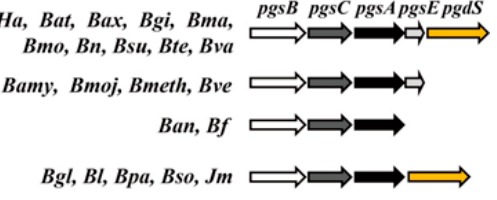
Figure 8. pgsBCAE and pgdS gene clusters. Bat , Bacillus atrophaeus ; Bax , Bacillus axarquiensis ; Bgi , Bacillus gibsonii ; Bma , Bacillus malacitensis ; Bmo , Bacillus mojavensis ; Bn , Bacillus nakamurai ; Bsu , Bacillus subtilis ; Bte , Bacillus thuringiensis ; Bva , Bacillus vallismortis ; Bamy , Bacillus amyloliquefaciens ; Bmoj , Bacillus mojavensis ; Bmeth , Bacillus methylotrophicus ; Bve , Bacillus velezensis ; Ban , Bacillus anthracis ; Bf , Bacillus flexus ; Bgl , Bacillus glycinfermentants ; Bl , Bacillus licheniformis ; Bpa , Bacillus paralicheniformis ; Bso , Bacillus sonorensis ; Ha , Halotolerans ; Jm , Jeotgalibacillus marinus .